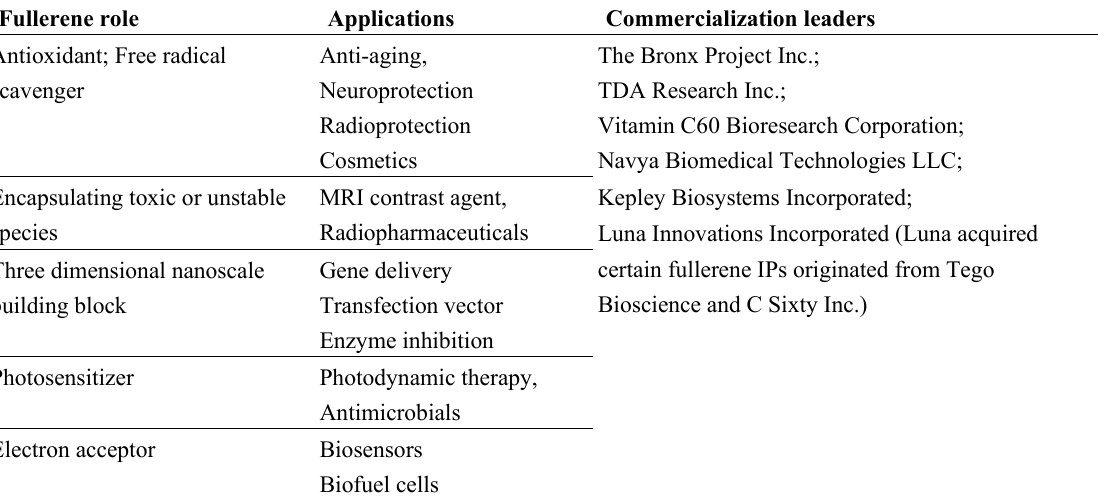
Table 1. Summary of biomedical applications of